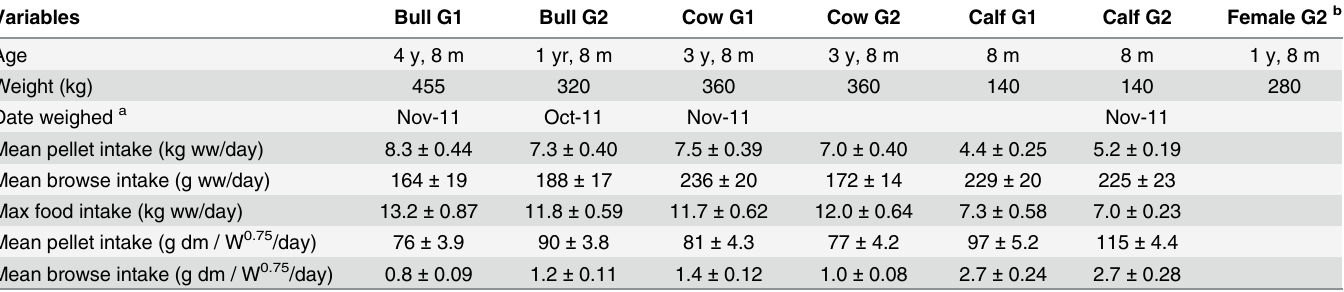
Table 1. The age and weight of the individual moose at the Sk å ne Zoo involved in this study during January and February 2012, and the observed mean and maximum daily intake of pellets and browse across the whole experiment (variation among days indicated by ± 1